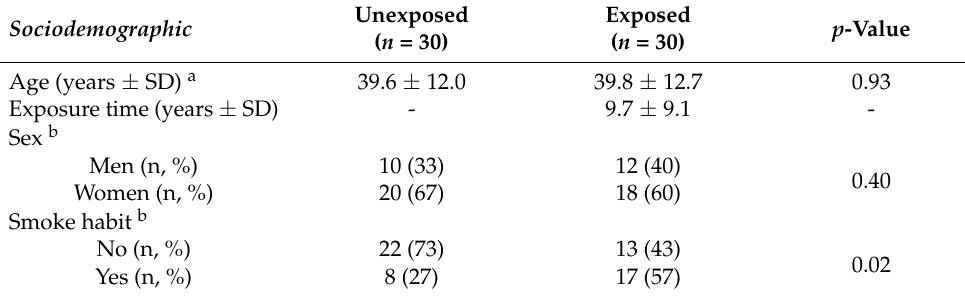
Table 1. General characteristics of study population.